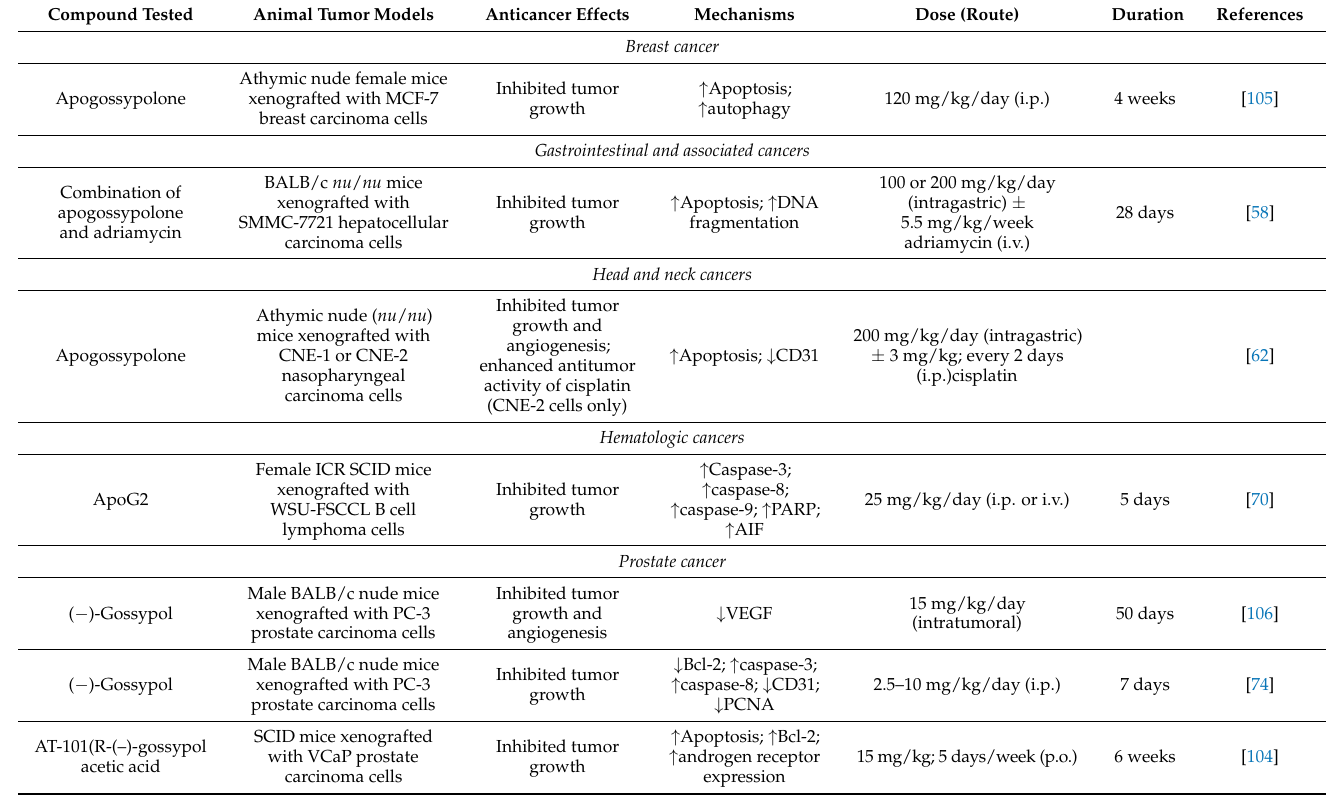
Table 4. Gossypol and their derivative’s activities against different types of in vivo cancer models.